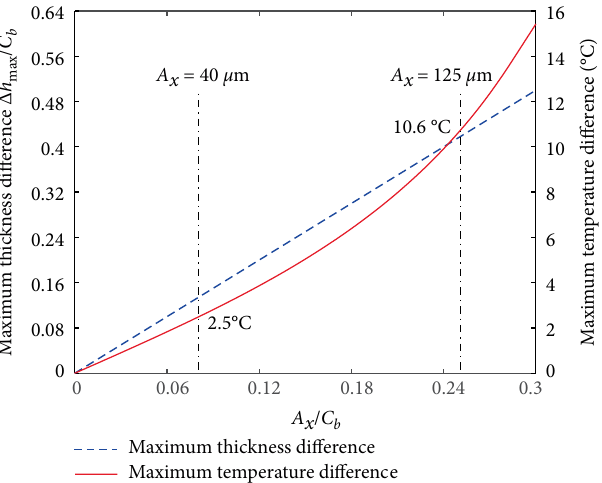
Figure 3: Maximum lubricant film thickness difference and maximum journal surface temperature difference under different whirl